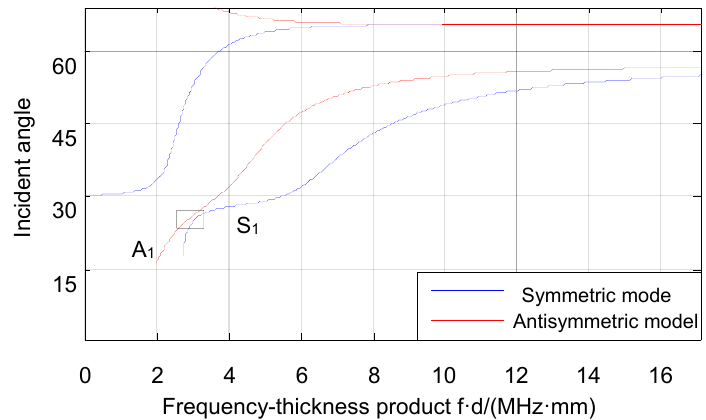
Figure 1. Experimental schematic.